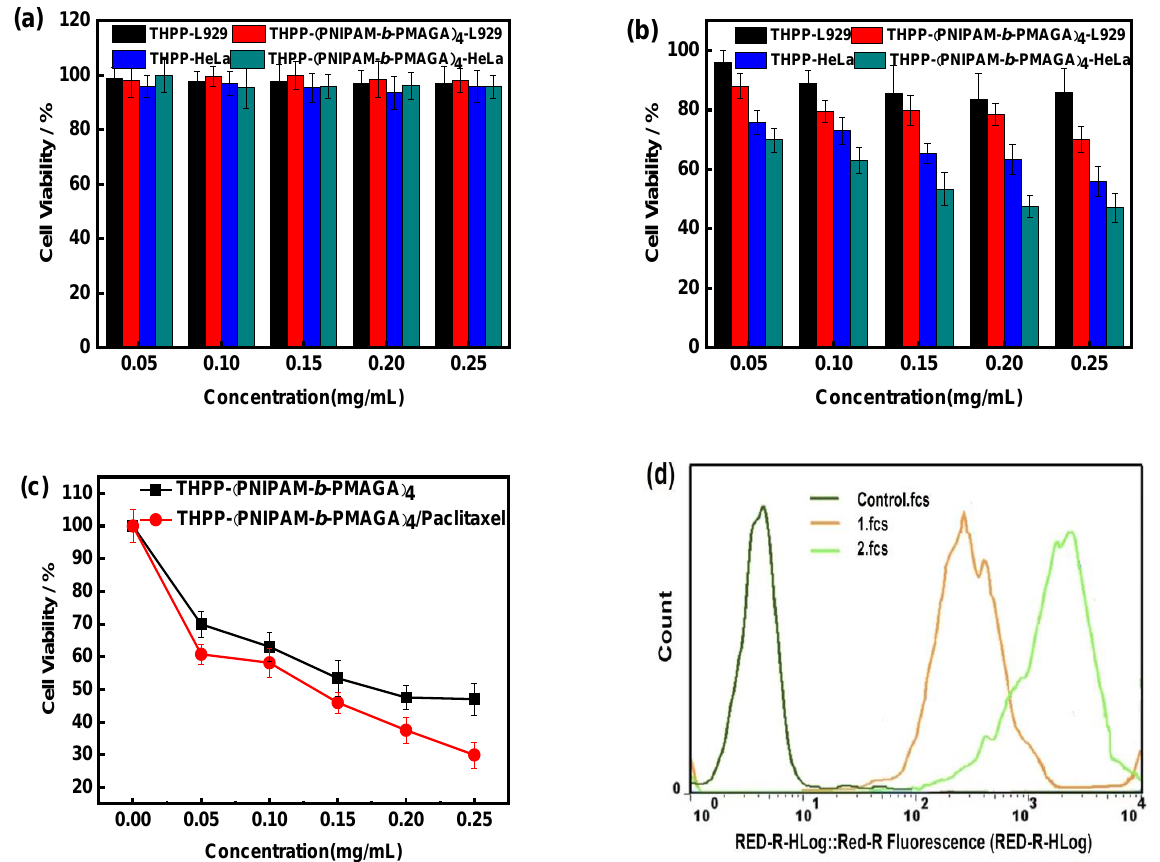
Figure 6. Viability of L929 cells and HeLa cells determined by the MTT assay after treatment of THPP and THPP-(PNIPAM- b -PMAGA) 4 micelles: ( a ) dark toxicity; ( b ) phototoxicity; ( c ) Viability of HeLa cells determined by the MTT assay after treatment of THPP-(PNIPAM- b -PMAGA) 4 and THPP-(PNIPAM- b -PMAGA) 4 /paclitaxel micelles; ( d ) Flow cytometric demonstration of HeLa cells after incubation with control (dark green line), THPP for 4 h (brown line), THPP-(PNIPAM- b -PMAGA) 4 for 12 h (green line).